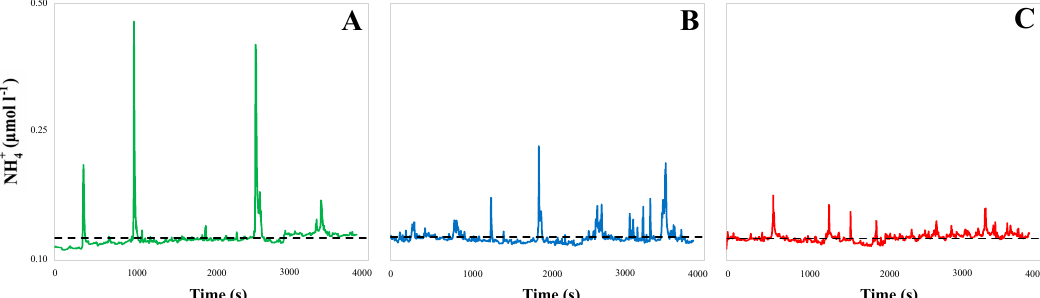
Figure 1. Samples of high-resolution (0.33 Hz) ammonium concentration time series recorded in the eastern English Channel in 1998 for increasing values of the tidal current speed v (m s − 1 ): v ~ 0.2 m s − 1 ( ε ~ 6 × 10 − 4 m 2 s − 3 , A ), v ~ 0.5 m s − 1 (i.e., ε ~ 7.5 × 10 − 5 m 2 s − 3 , B ), and v ~1 m s − 1 ( ε ~ 4.8 × 10 − 6 m 2 s − 3 , C ). The ammonium distributions are patchier when the hydrodynamic conditions (i.e., the tidal current speed v ) are weaker. The dissipation rate of turbulent energy ε (m 2 s − 3 ) were estimated from the velocity of the tidal flow v as ε = 0.006 ( v 3 / z ), where z is the depth of the water column ( z ~ 10 m); see Equation (15) below. The black dashed lines are the average of each distribution, and illustrate the extreme similarity in the bulk concentration of ammonium.